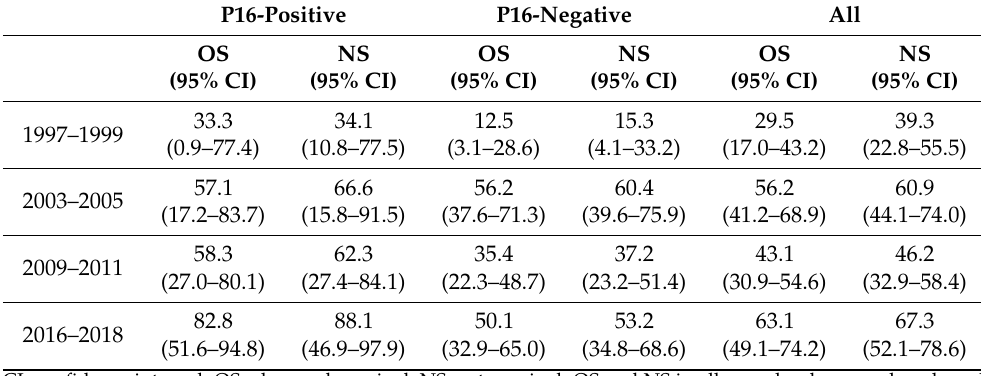
Table 6. Five-year observed and net survival rates according to p16 expression, stratified by period.